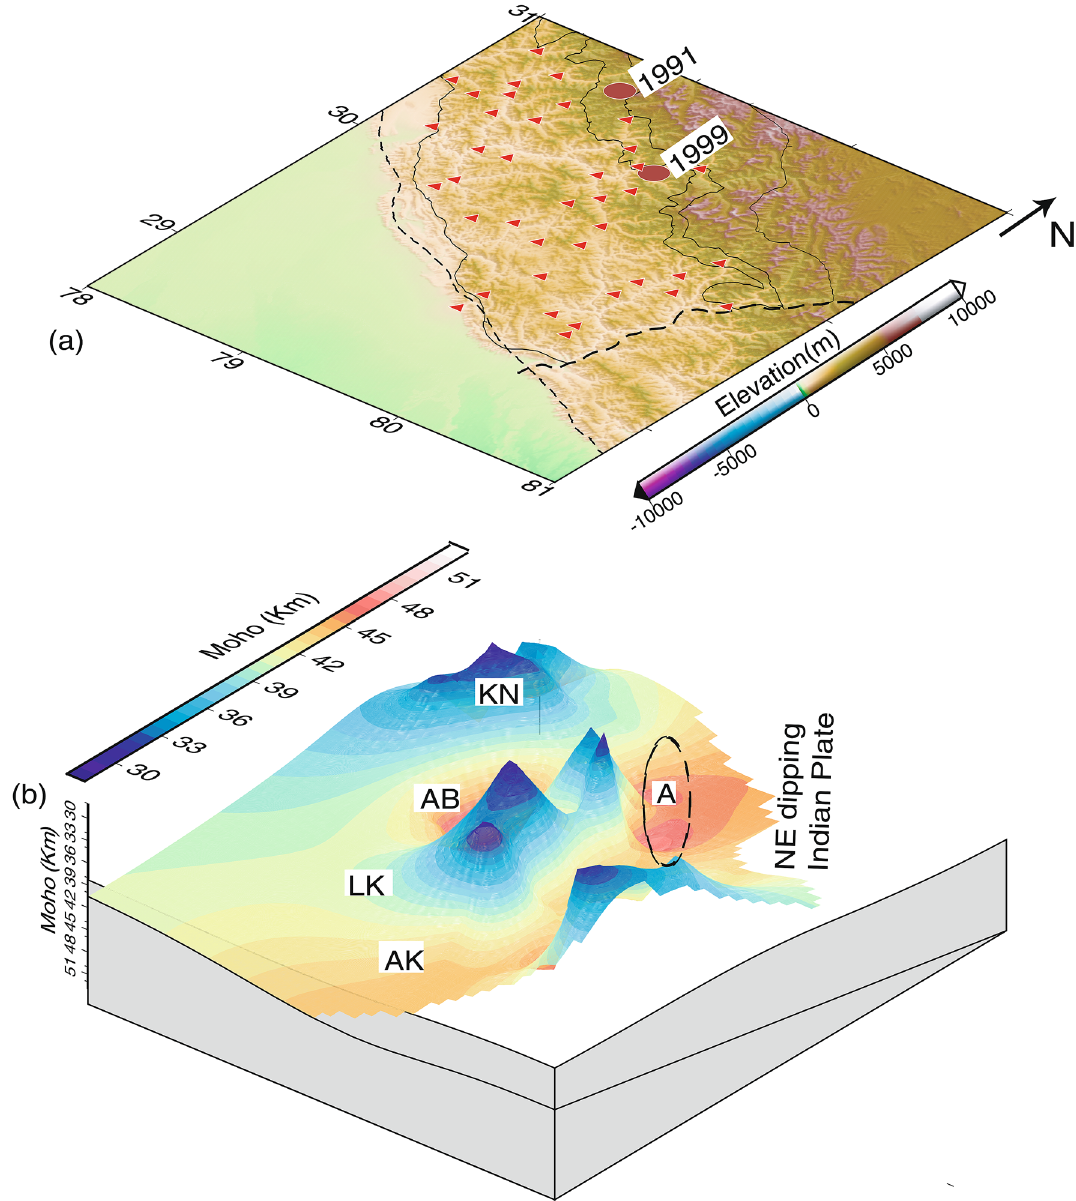
Figure 5. ( a ) Elevation (in m) map along with seismic stations (marked by red filled triangles). While two large red filled circles represent the locations of the 1991 M w 6.6 Uttarkashi and 1999 M w 6.4 Chamoli earthquakes. 3-D surface plots of modelled ( b ) Moho (km). The zone-A where maximum changes in Moho depths are modelled while “NE dipping Indian plate” marks the inferred north-easterly subducted Indian Moho. And, AK, LK, AB and KN mark the approximate locations of Almora Klippe, Lansdowne Klippe, Alkananda basin and Kroll Nappe,